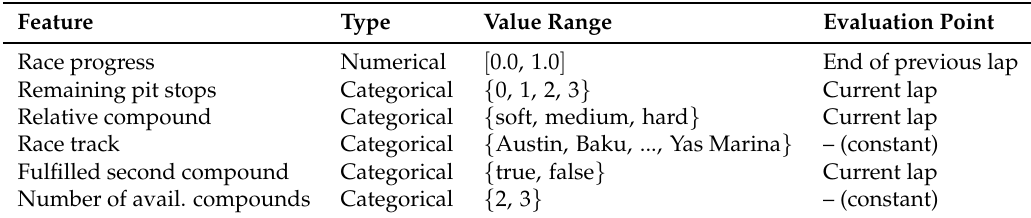
Table 7. Input feature set for a neural network to take the compound decision.